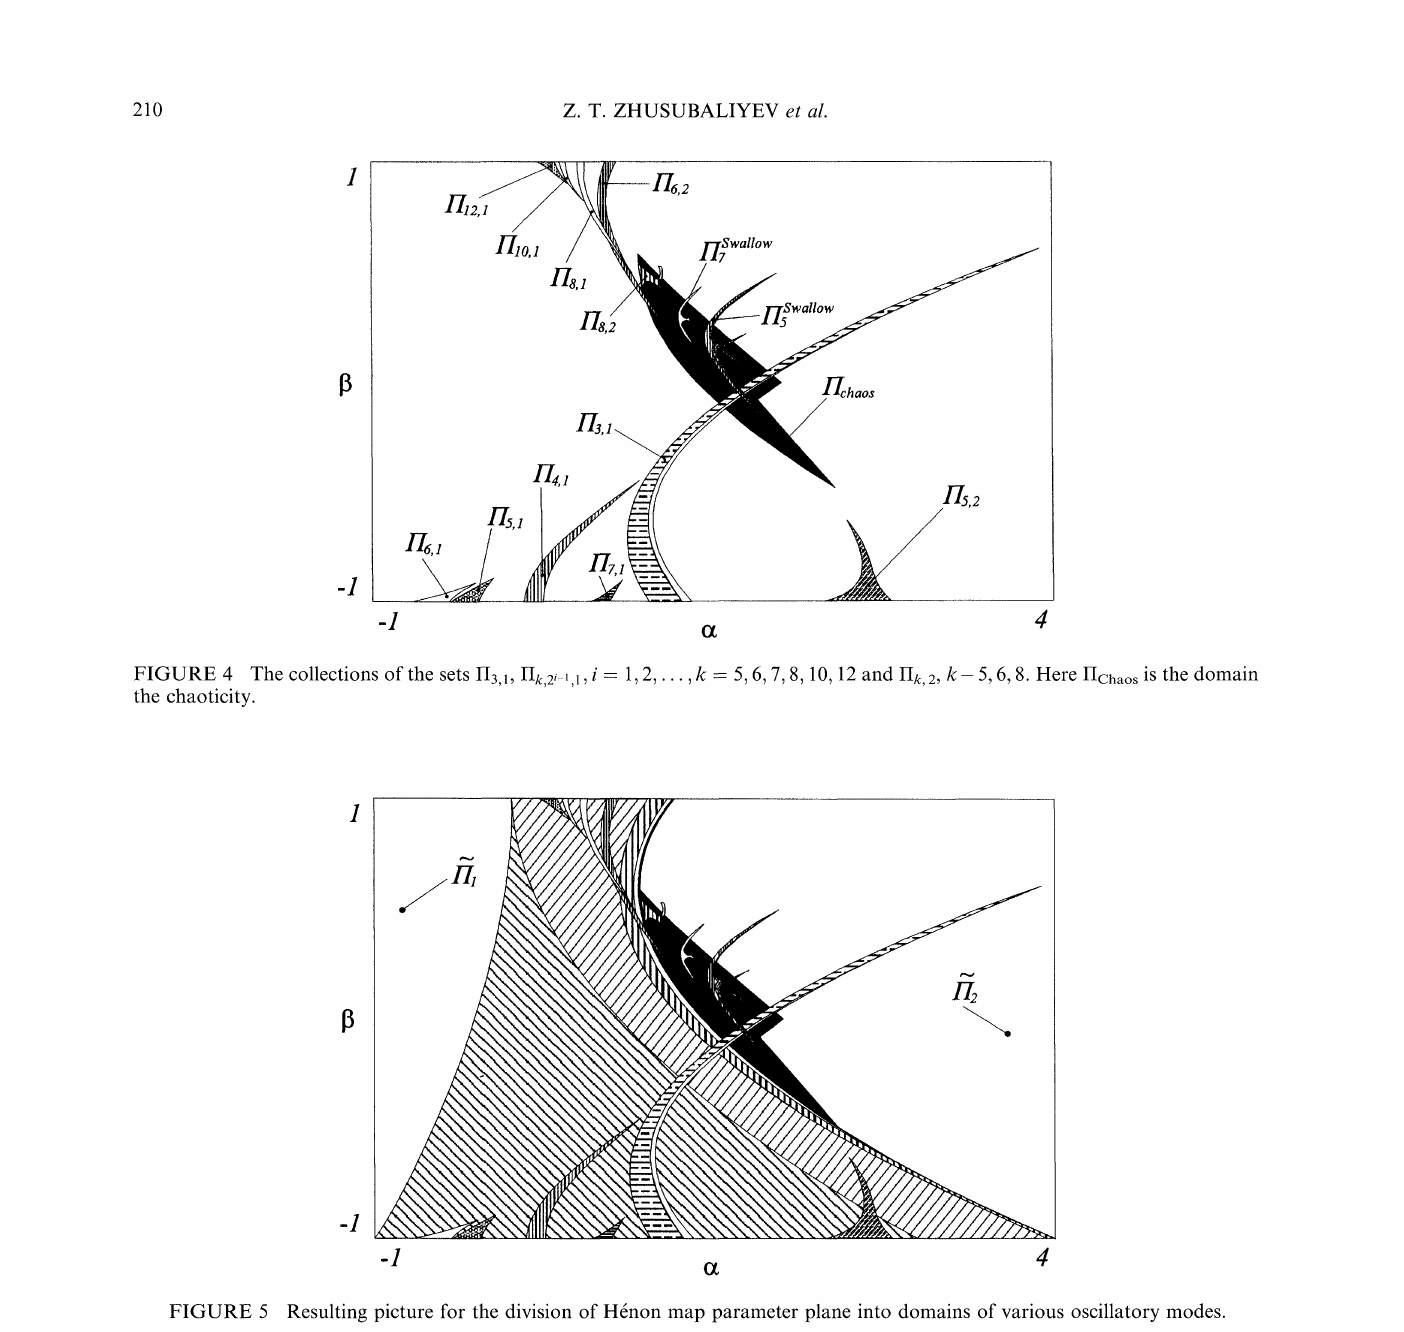
FIGURE 5 Resulting picture for the division of H6non map parameter plane into domains of various oscillatory